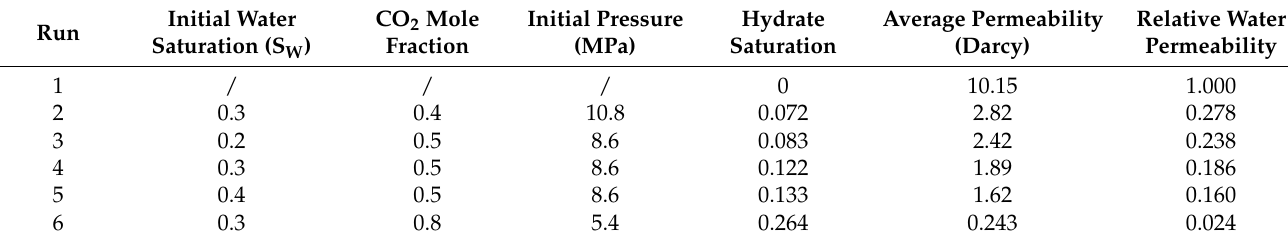
Table 1. Experimental conditions and